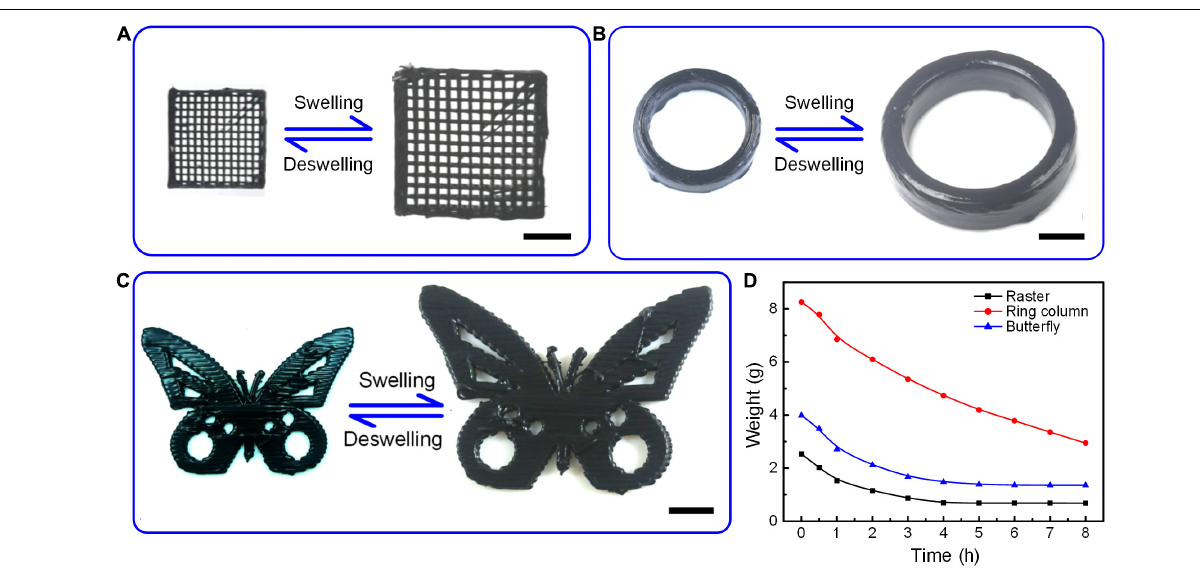
structure can recover to the original shape at the fastest speed (4 h), while the butterfly shaped sample can recover the initial shape in about 5 h. However, because there are more areas that are not in direct contact with the air, the rate of water loss of the sample with ring column shape is the slowest, requiring more than 8 h. If the swollen samples are placed at room temperature, it will take longer to fully recover the original